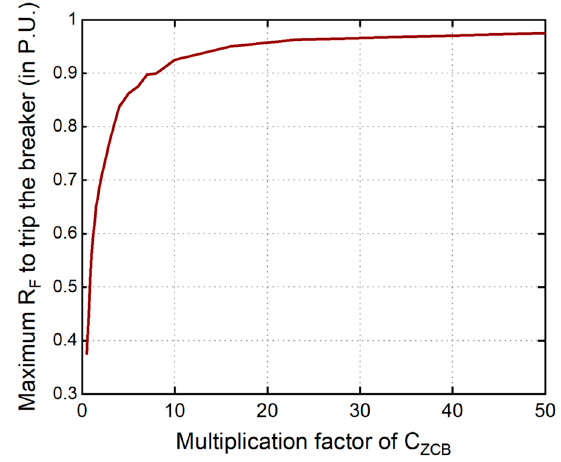
Figure 3. Graph of the R F limit in response to the multiplication factor in C ZCB , for high impedance fault (HIF) detection/interruption specification in ICC-BZCB.